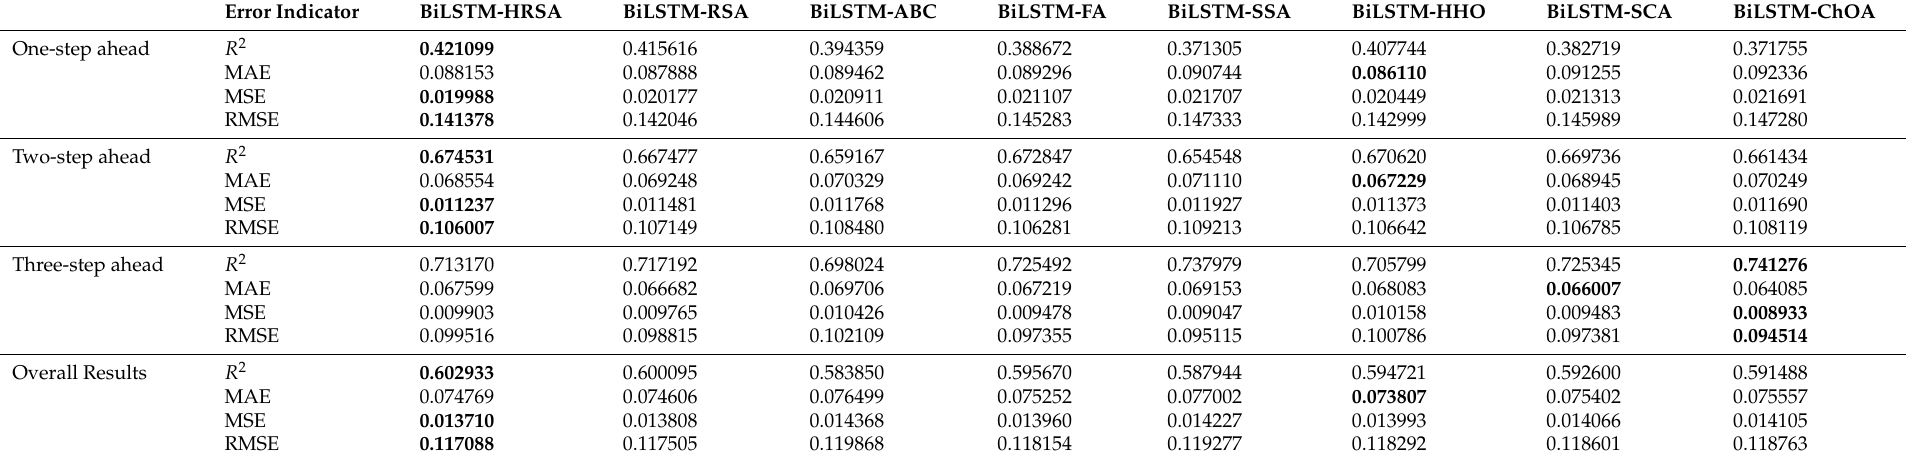
Table 6. Normalized metrics for one-step, two-step, three-step ahead, and overall predictions for BiLSTM experiments. The best result in each column is written in bold.